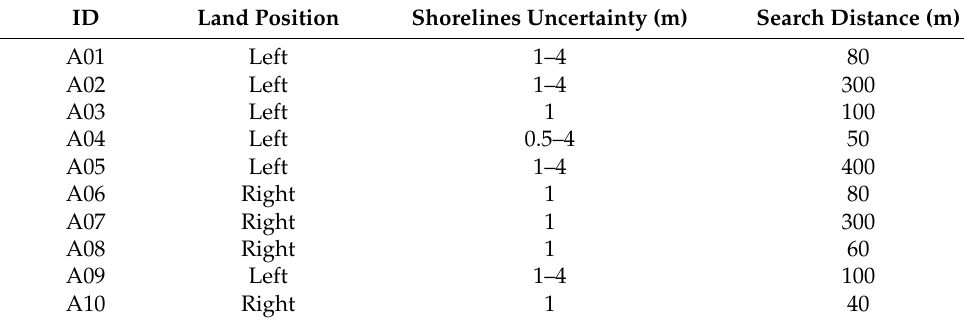
Table 2. Main parameters used in setting up DSAS for each study site.